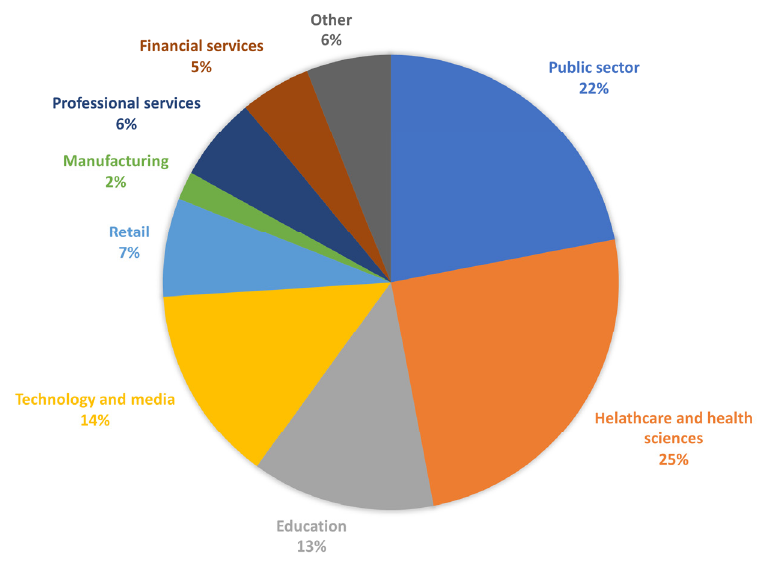
Figure 2. Most Vulnerable